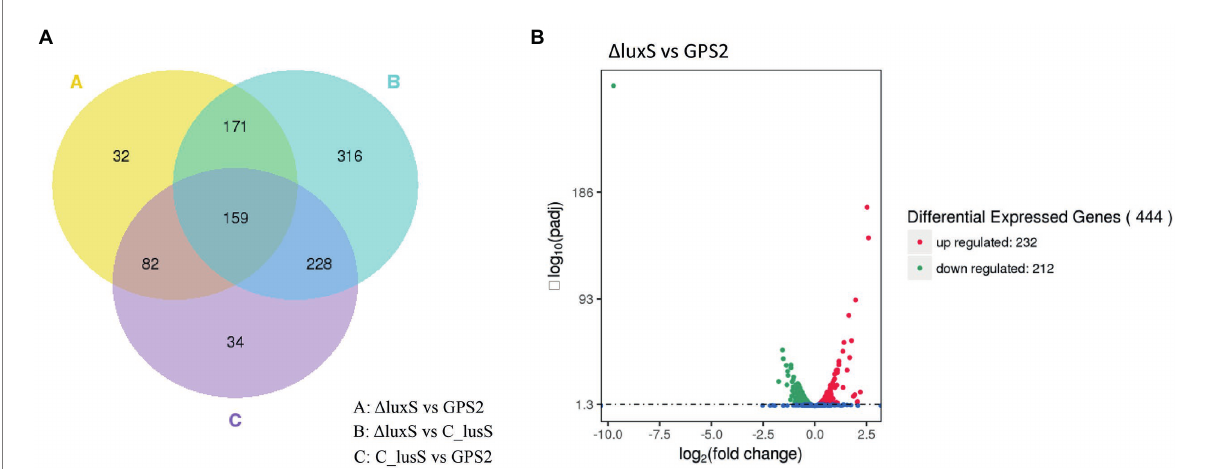
FIGURE 1 (A) Venn diagram of differentially expressed genes. “A” means differentially expressed genes between GPS2 and Δ luxS groups; “B” means differentially expressed genes between Δ luxS and C-luxS groups; “C” means differentially expressed genes between GPS2 and C-luxS groups. (B) Volcano plot of differentially expressed genes between Δ luxS and GPS2 groups. Red dots represent up-regulated genes; green dots represent down-regulated genes; and blue dots represent non-differentially expressed